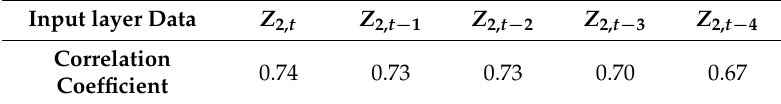
Table 2. Correlation coefficients between input layer data and the output layer.